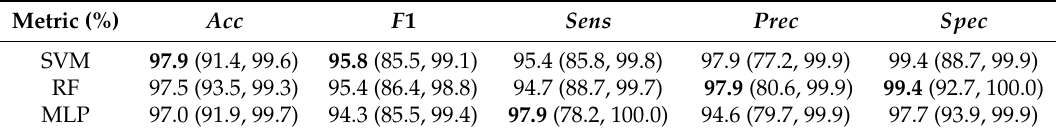
Table 3. The median and 95% confidence intervals for all adopted metrics are reported to compare different learning methods. In bold, we reported the higher values for each